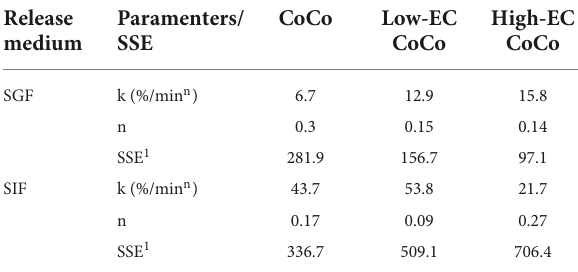
TABLE 2 Parameter estimates from fitting the release of limonene from CoCo, low-EC CoCo and high-EC CoCo microcapsules in SGF and SIF over time ( Figures 6B,C